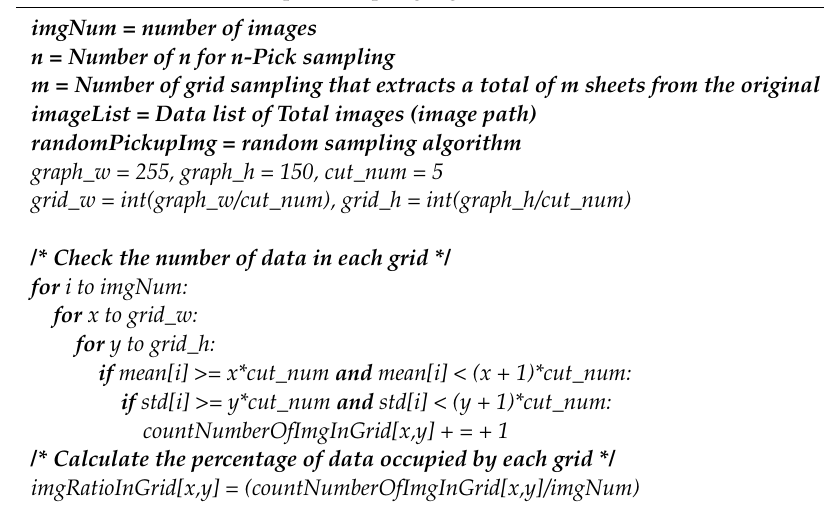
Algorithm 1: Grid and n-pick sampling